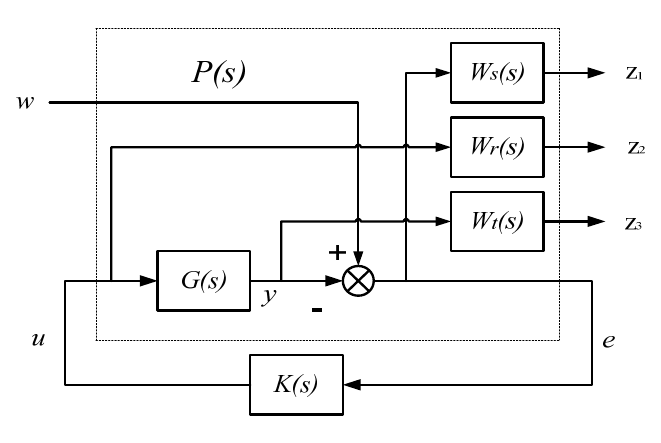
Figure 3. Mixed-sensitivity